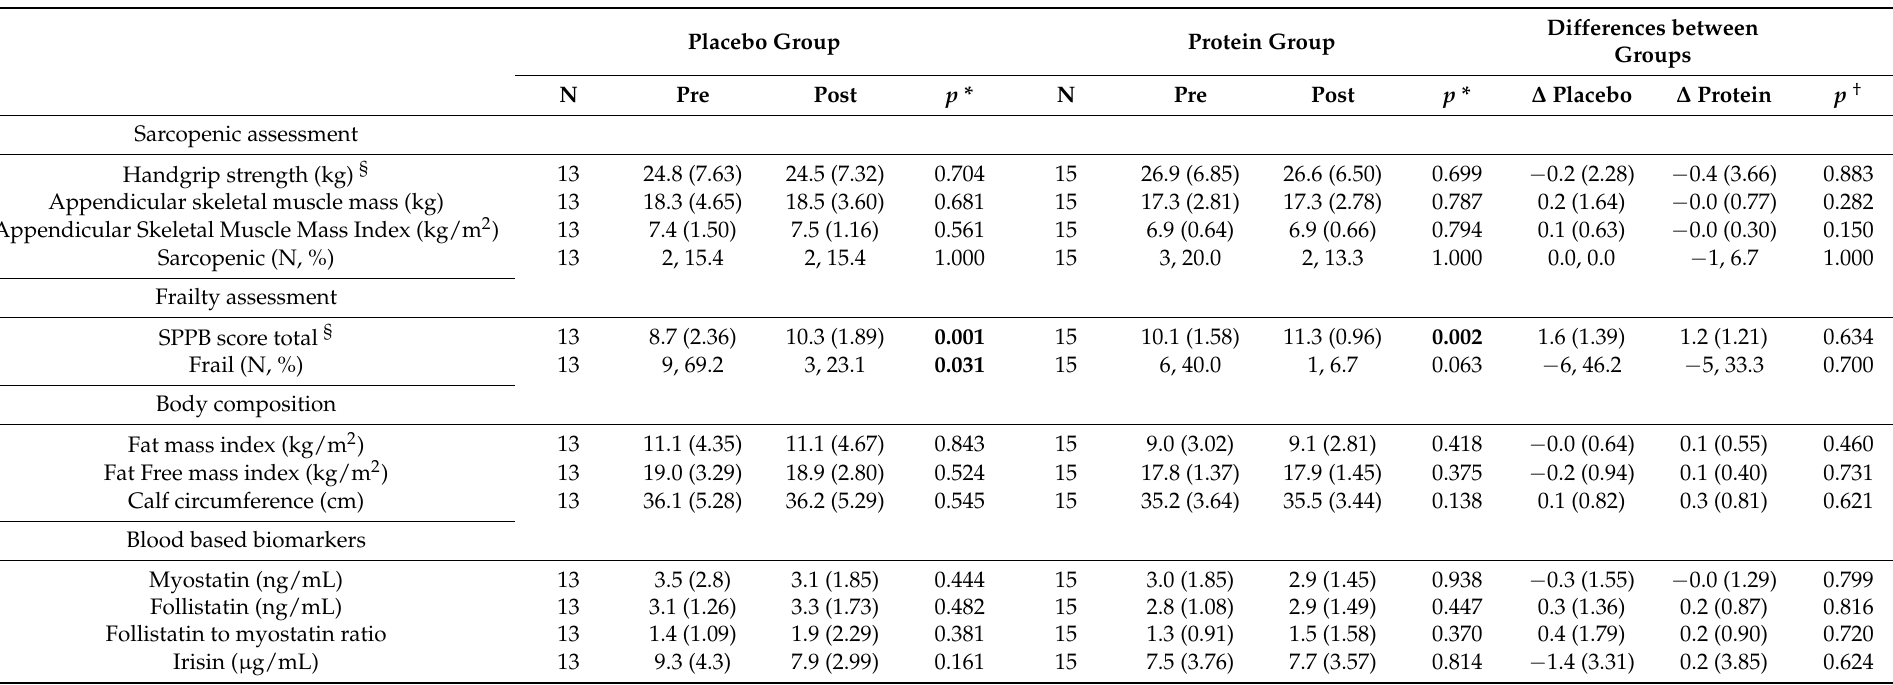
Table 2. Body composition, nutritional status and physical function in elderly patients before (pre) and after (post) their participation in the resistance